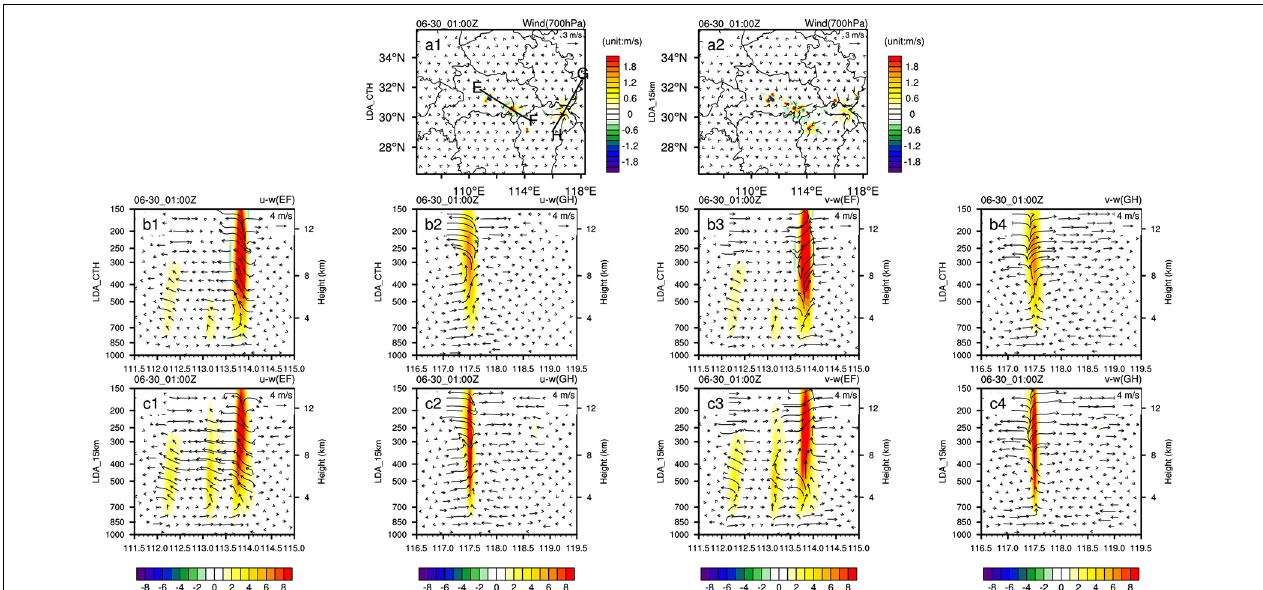
FIGURE 8 | The difference in horizontal wind vectors (a1,a2) at 700 hPa and vertical cross sections of the u-w vectors (b1,b2,c1,c2) , v-w vectors (b3,b4,c3,c4) , and vertical velocity between LDA_CTH ( a1 and the second row)and LDA_15km ( a2 and the third row) with CTL for 0100 UTC on 30 June 2018. The legend for the colors for the vertical velocity is shown to each panel. The black lines EF and GH in (a1) denote the locations of the vertical cross sections for subsequent figures. For vertical cross sections, the first and third columns show the cross section along line EF, and the second and fourth columns show the cross section along line GH.